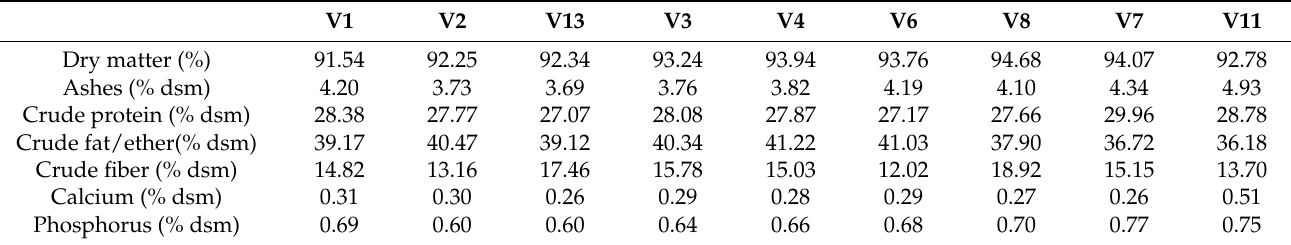
Table 5. Nutrient composition (%) of Camelina sativa